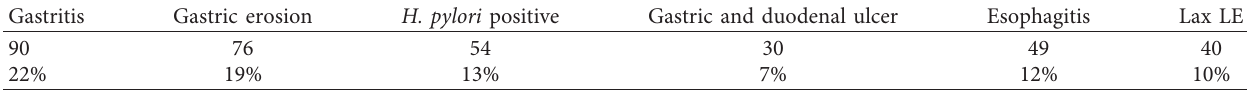
Table 3: Comparison of UGI scope findings in group B patients.